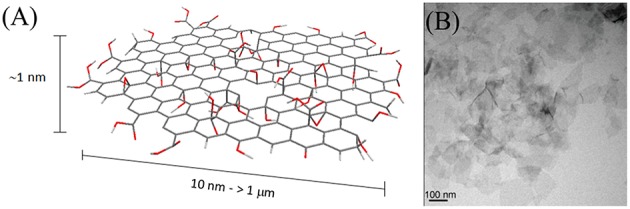
(A) Schematic representation of GO. The nanomaterial surface and edges are characterized by the presence of carboxyls, carbonyls, alcohols, and epoxydes. (B) TEM micrograph of GO sheets; adapted from Zhang L. et al. (2010) with permission from John Wiley and Sons, Copyright (2010).